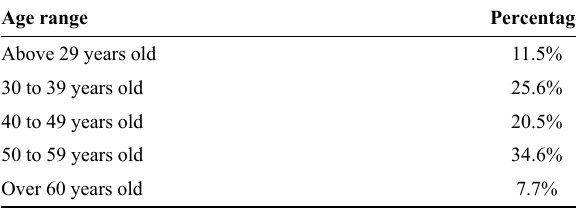
Table 1 - Age distribution of sport managers.